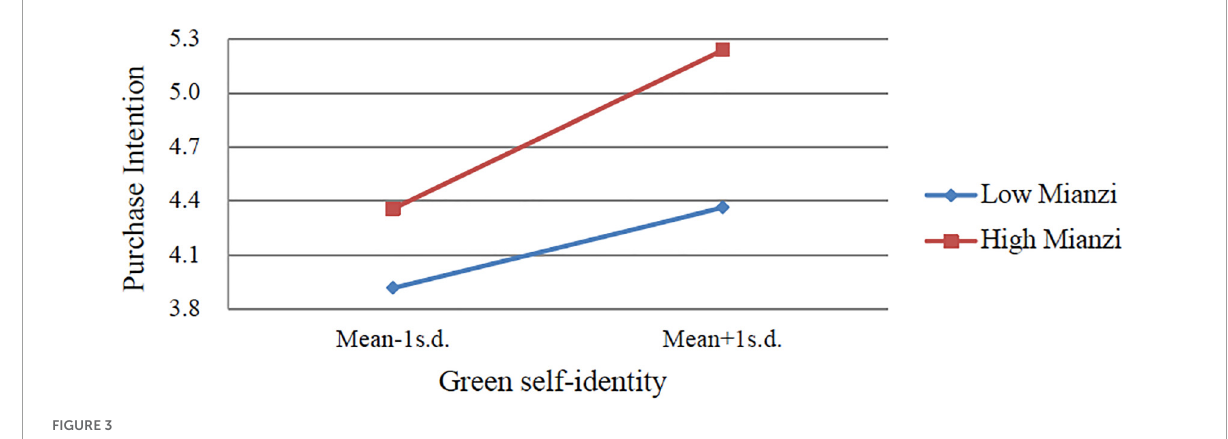
FIGURE3 The moderating effect of “mianzi.”